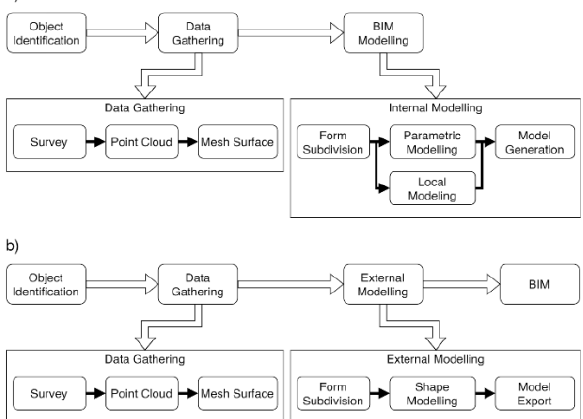
Figure 1 . a (above) Standard Scan-to-BIM workflow with modelling inner BIM, b (below)- Scan-to-BIM workflow involving modelling tools external to BIM.